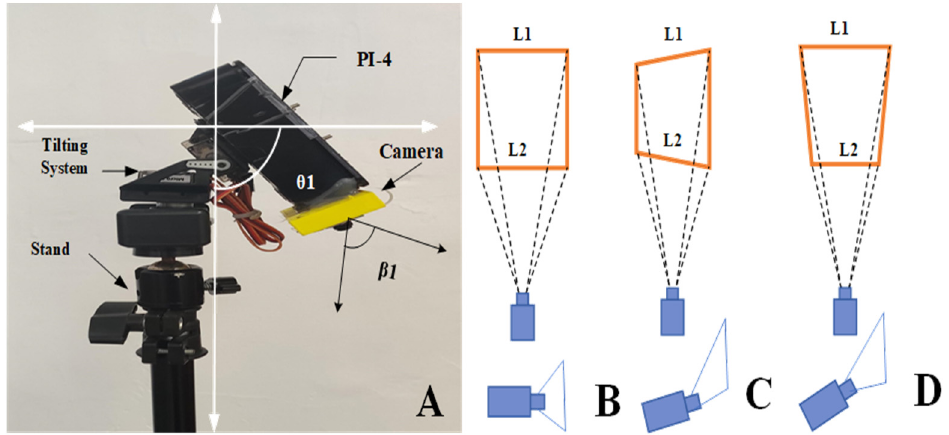
Figure 7. Indoor setup for the tilt system with the servo bed. ( A ) tilt system assembly, consisting of two servo motors capable of moving in the x and y axis along with raspberry PI 4B, pi camera. ( B ) the image and camera situation in a different scenario, parallel to the surface, ( C ) horizontally angled, ( D ) vertically tilted, L1: base 1 and L2: based 2.